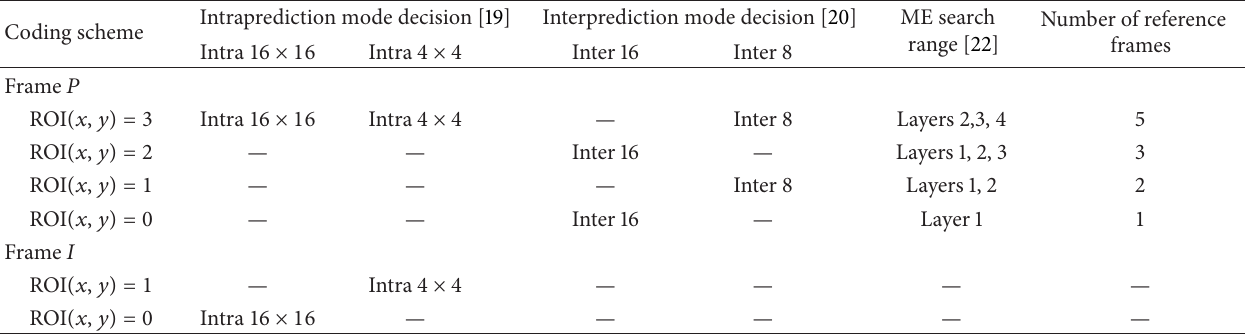
Table 1: The hierarchical video coding algorithm based on visual perception characteristics. Coding scheme